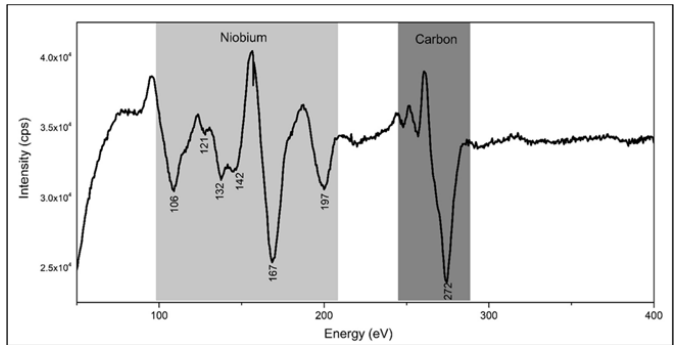
Figure 3. AES spectrum of NbC 1223 K for 4 h.